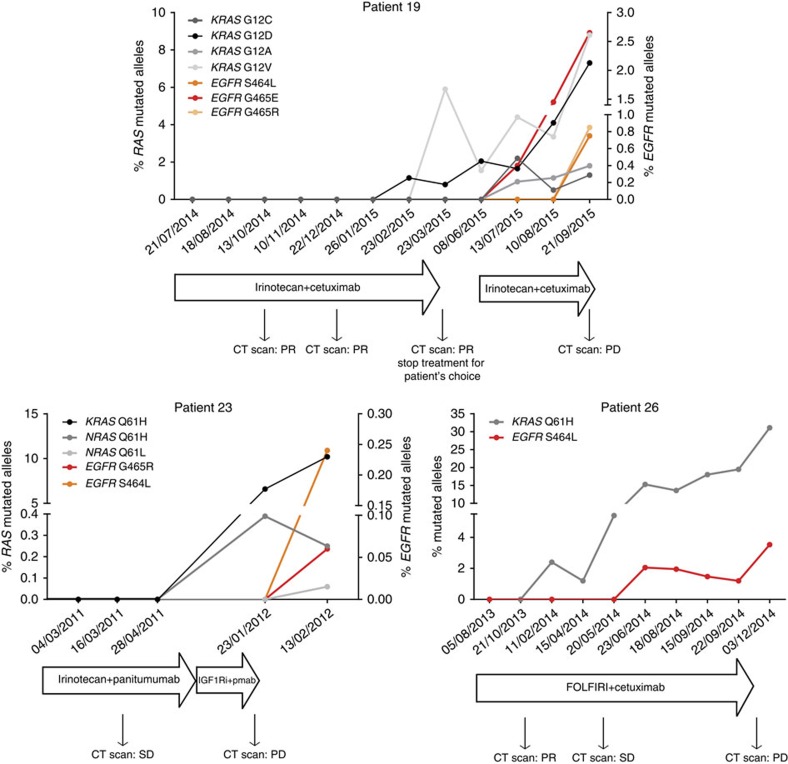
Longitudinal analysis of plasma ctDNA collected during anti-EGFR therapy.Shades of black and grey indicate frequency of circulating RAS mutant alleles; and shades of red and orange indicate frequency of circulating EGFR mutant alleles. All patients achieved partial response or disease stabilization under EGFR blockade administered alone or in combination with standard chemotherapy. RAS mutant clones are apparent in the circulation months earlier than EGFR clones in all of the three cases. CT, computed tomography; PD, progressive disease; Pmab, panitumumab; PR, partial response; SD, stable disease.